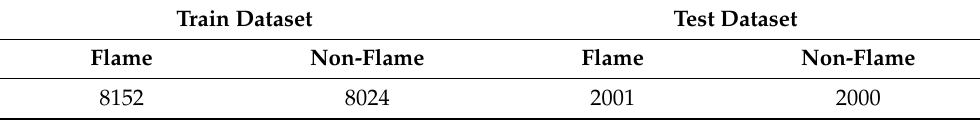
Table 3. Number of images in the dataset.